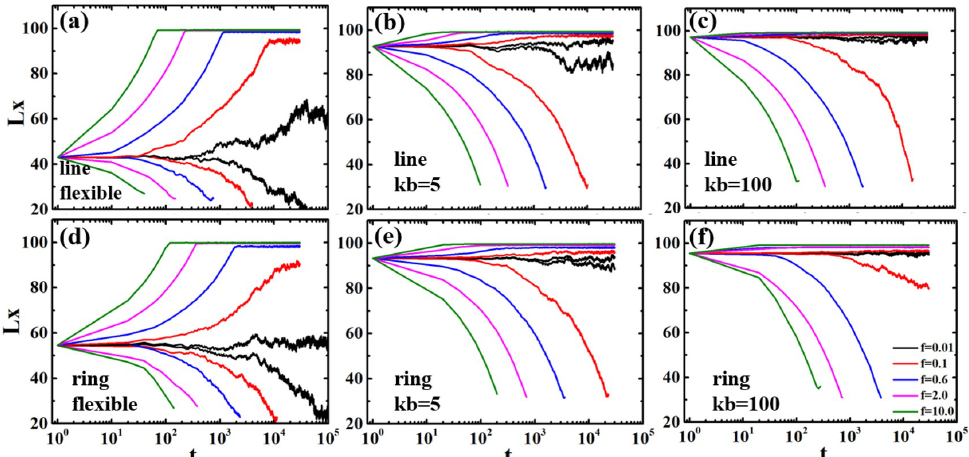
Figure 9. The lengths along the tube L x as functions of time t of linear and ring polymers with different rigidities under external force f confined in channel diameter d = 10. ( a ) Flexible linear polymer; ( b ) Semiflexible linear polymer with k b = 5; ( c ) Semiflexible linear polymer with k b = 100; ( d ) Flexible ring polymer; ( e ) Semiflexible ring polymer with k b = 5; ( f ) Semiflexible ring polymer with k b =